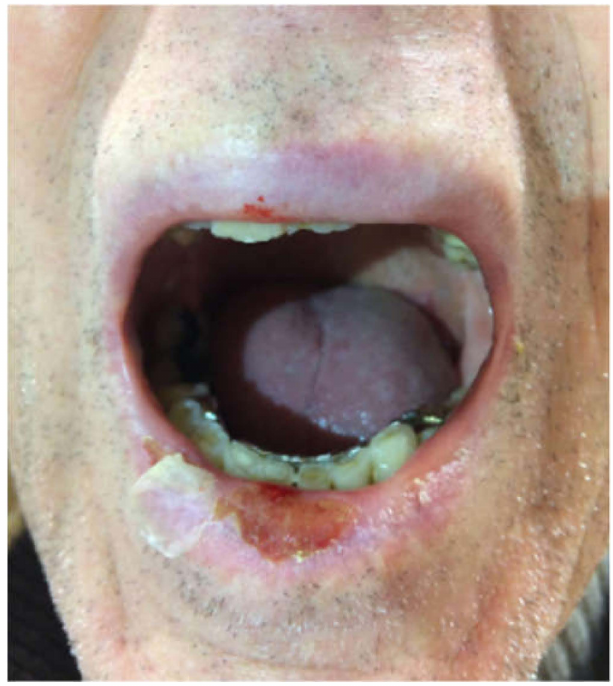
Figure 4. Oral involvement of a bullous pemphigoid in a patient in immunotherapy with Anti-PD1